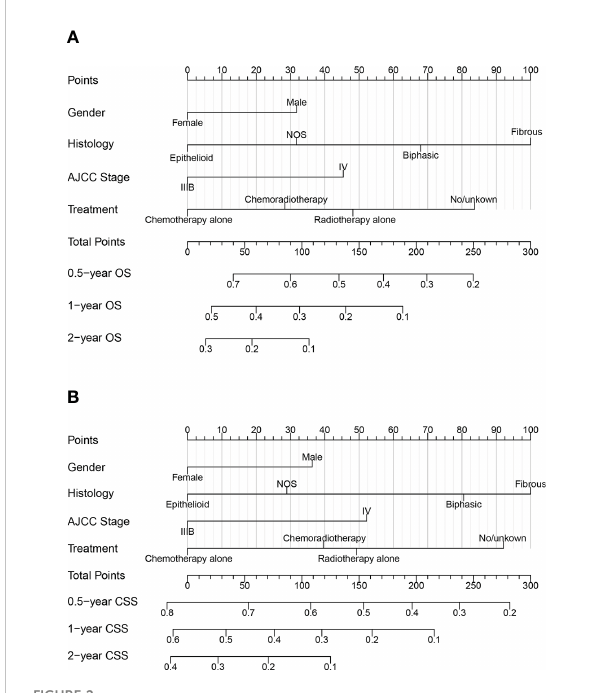
FIGURE 2 Nomograms for predicting 0.5, 1, and 2year (A) OS and (B) CSS of patients with advanced MPM.